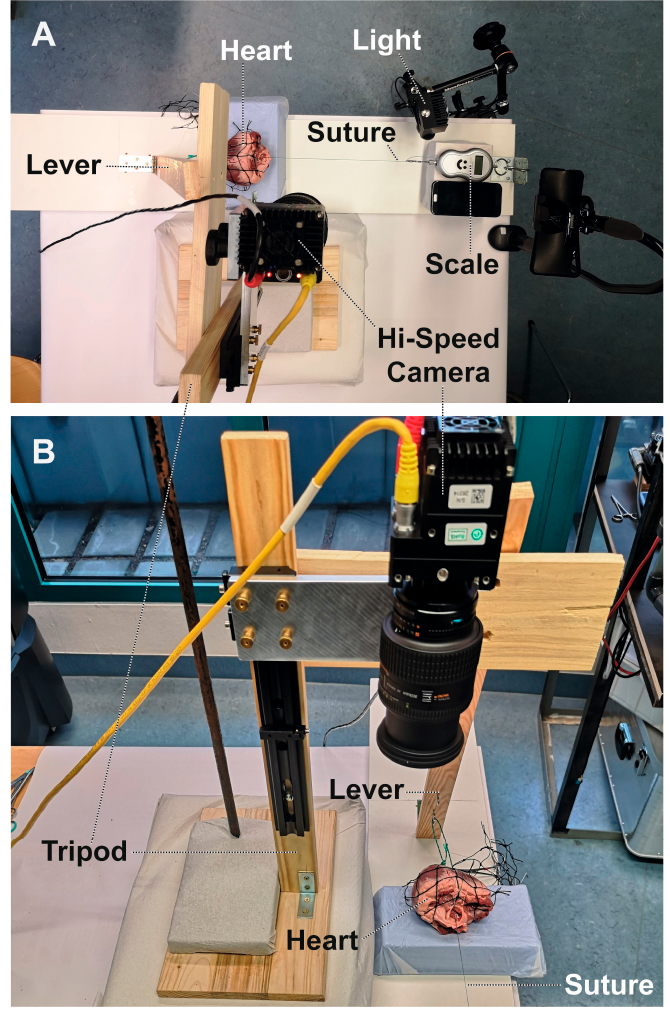
Figure 2. Experimental setup. ( A ) Top view. The heart was mounted in a ‘stretching bench’ where increasing traction force could be applied to a single pledgeted annular suture. Force was generated by slowly pulling a lever and measured with a luggage scale. ( B ) Front view. The motion of the respective Teflon pledget was continuously filmed with a high-speed camera at 1000 frames per second and recorded for offline analysis. The entire procedure was repeated for each suture and for all hearts one after another.